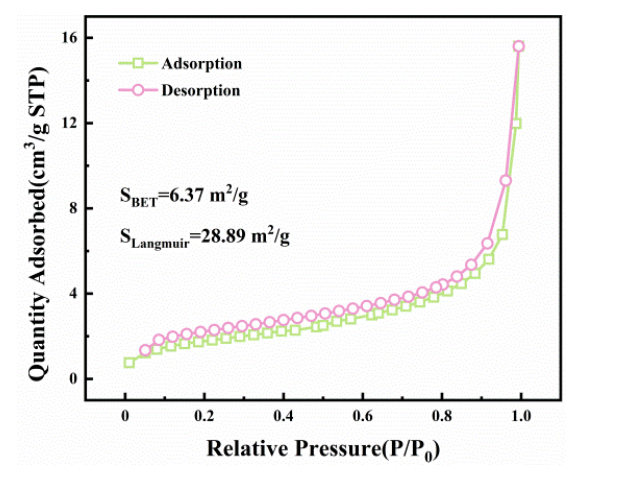
Figure 4. N 2 adsorption and desorption measurements and pore size distribution of ( a ) PAN and ( b ) PAN/TpPa ‐ SO 3 H at 77 K.